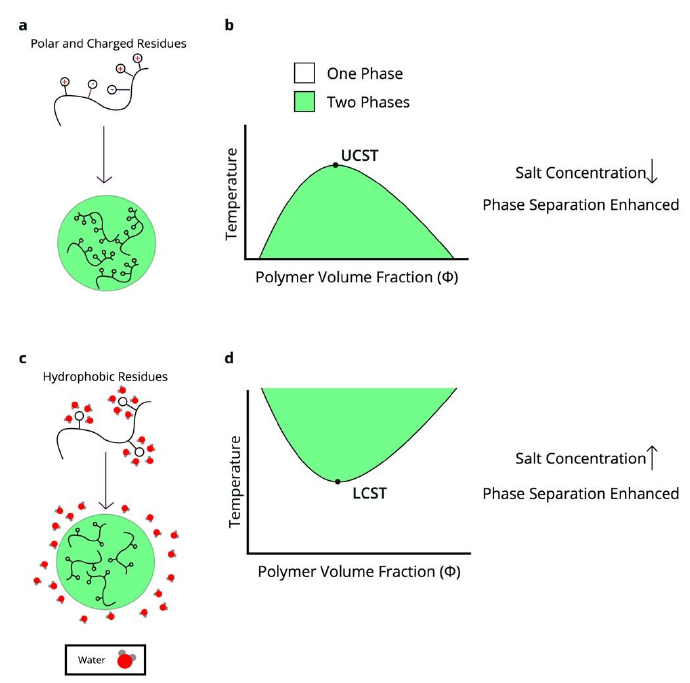
Figure 1. Trends in stimulus responsiveness of phase-separated condensates. ( a ) Condensation of proteins driven by polar and/or charged residues typically generates condensates ( b ) that phase separate at low temperatures and low salt concentrations; ( c ) condensation of proteins driven by hydrophobic interactions frees some water molecules; this typically generates condensates ( d ) that phase separate at high temperatures and high salt concentrations. There are exceptions depending on the precise thermodynamics of the polymer phase separation; for example, FUS LC phase separates at low temperatures but at high salt concentrations [19].